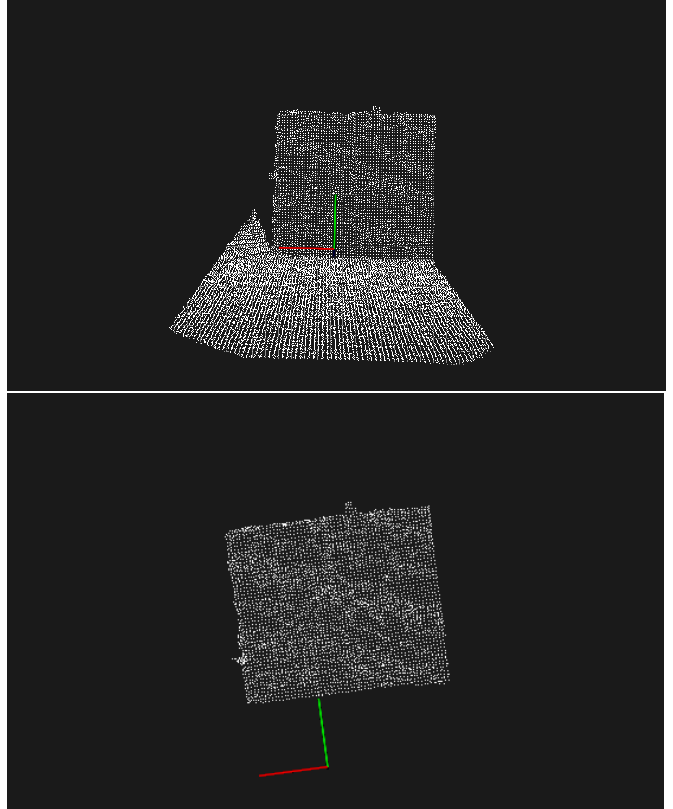
Figure 5. The stages of processing the point cloud: (top) the high-resolution point cloud extracted from the Kinect sensor; (middle) the point cloud after the elimination of non-relevant points and downsampling; and (bottom) the points of an obstacle, after the floor plane was identified and removed from the image using